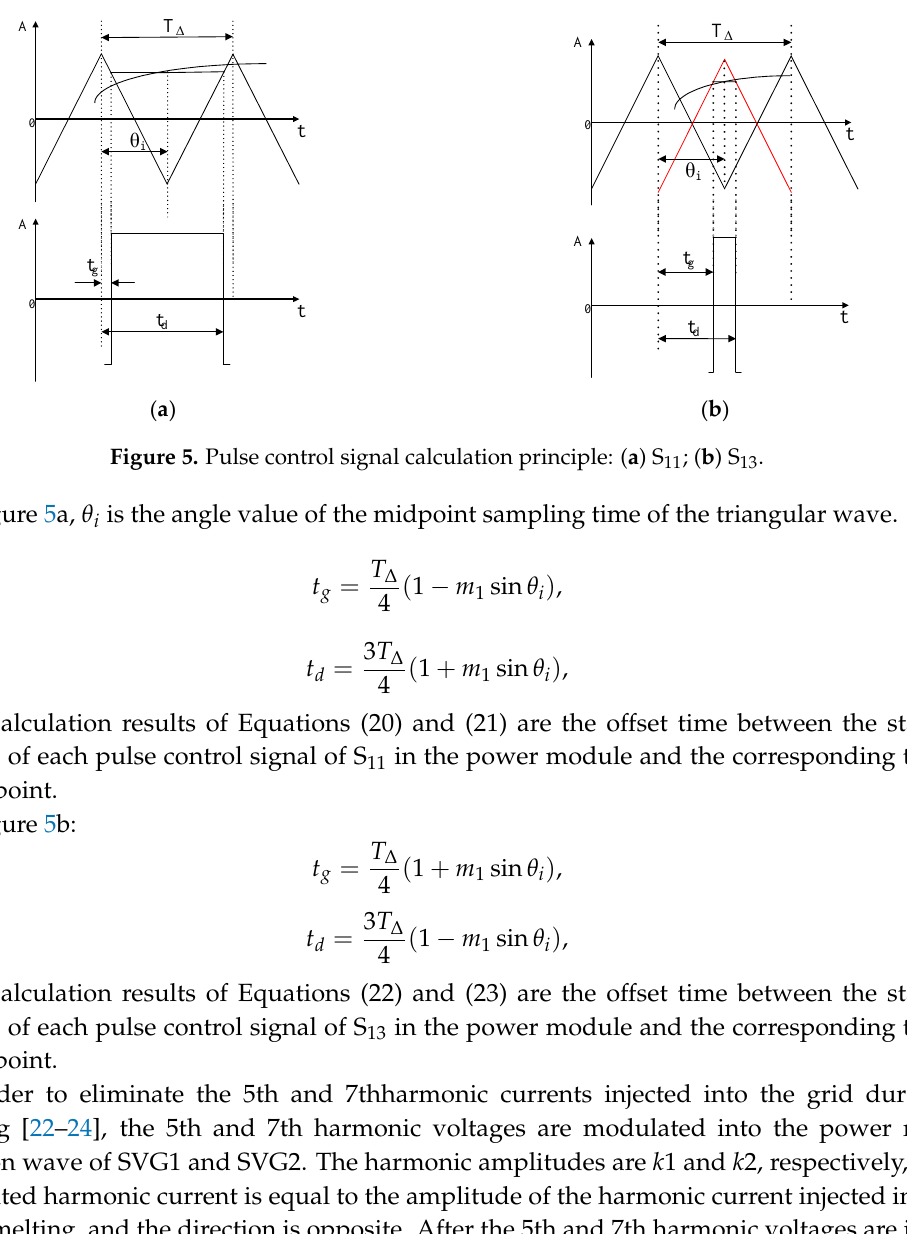
( b ) Figure 4. Modulation: ( a ) Carrier phase-shifted modulation (Different colors represent different carriers); ( b ) sine pulse width modulation.